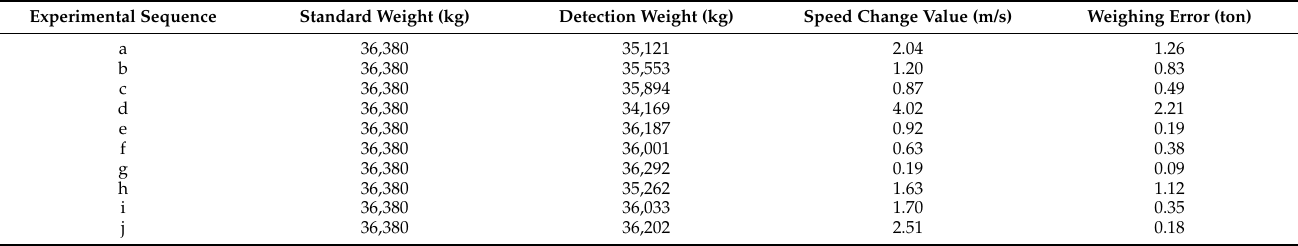
Table 4. Validation experimental results